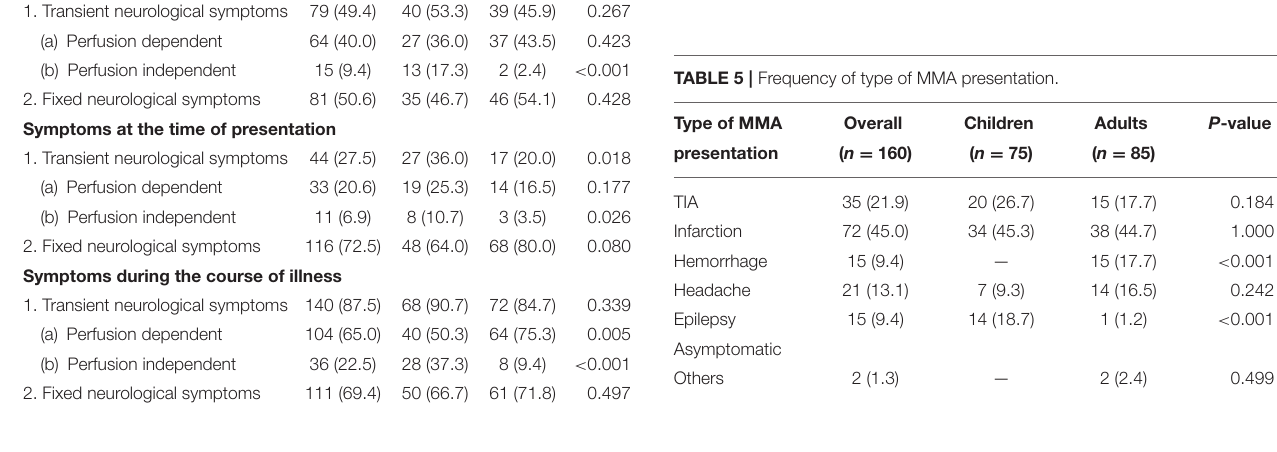
TABLE 4 | Comparison between first neurological symptom and latency of diagnosis. First neurological